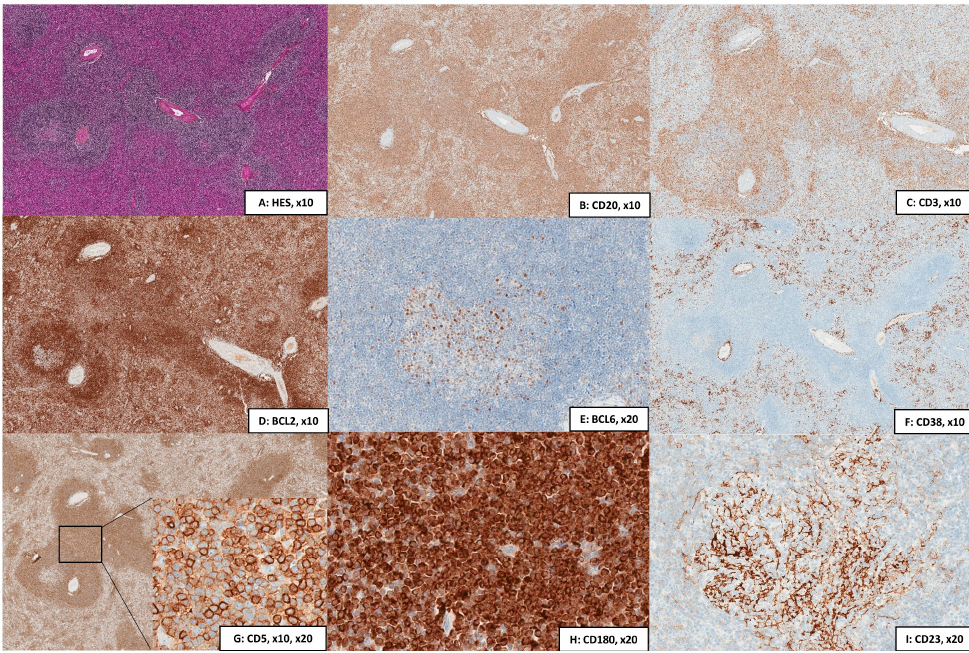
Figure 2. Immunohistochemical patterns of SMZL. ( A ) Hematoxylin–eosin–safran (HES) staining showing a nodular (monophasic pattern) with the enlargement of the white pulp (magnification: 10×); ( B ) CD20 staining showing the hyperplasia of the white pulp with a variable involvement of the red pulp (magnification: 10×); ( C ) CD3 staining by immunohistochemistry also showing variable numbers of CD3 + T cells (magnification: 10×); ( D ) BCL2 showing that SMZL cells overexpressed BCL2 (magnification: 10×); ( E ) BCL6 expressed in residual germinal centers but not on tumoral cells (same staining using CD10; magnification: 20×); ( F ) CD38 staining highlighting a large number of associated plasma cells (mag- nification: 10×) ; ( G ) CD5 staining of a CD5 + SMZL, with weaker staining on B-cells than on T cells of the microenvironment (magnifications: 10× and 20×); ( H ) CD180 staining in SMZL (magnification: 20×); strong membranous and cytoplasmic positivity with perinuclear accentuation; ( I ) CD23 staining highlighting a nodular meshwork of follicular dendritic cells in the white pulp (magnification: 20×).